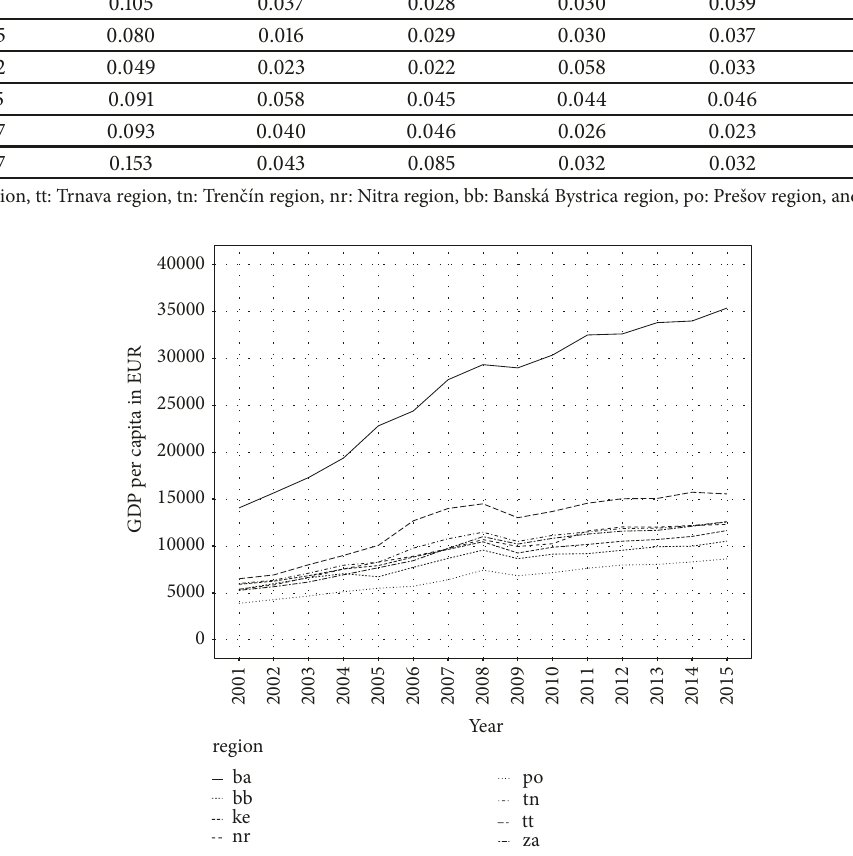
Figure 4: GDP per capita in Slovak